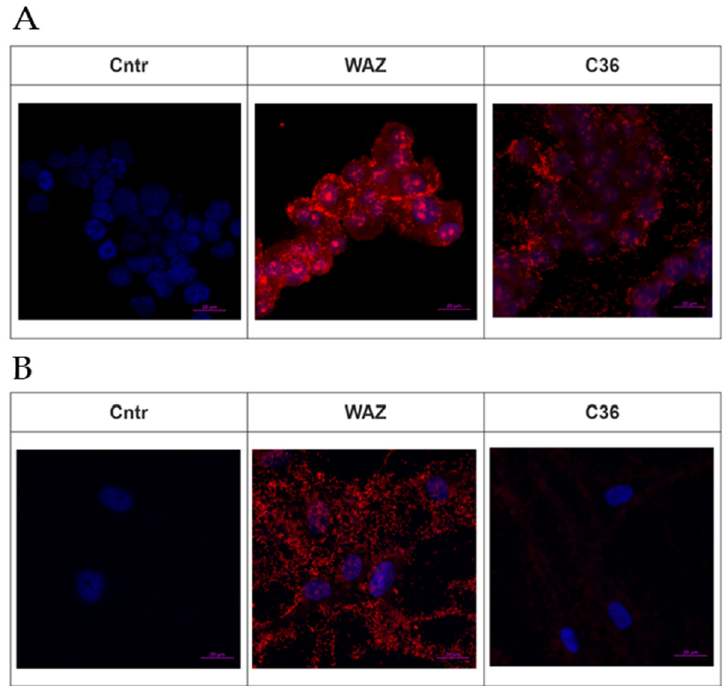
Figure 1. Cytochemical staining of U-87 MG human glioblastoma cells ( A ) and normal human fibroblasts hFF8 ( B ) using a SulfoCy5-labeled Waz 2 (cid:48) -F-RNA aptamer and scrambled control RNA C36 (see Materials and Methods section (Section 4.5) for abbreviations and nucleotide sequences). DAPI-stained nuclei, blue signal; Cy5-labeled aptamers and scrambled controls, red signal. On the contrary, control scrambled 2 (cid:48) -F-RNA oligonucleotide C36 (sequence taken from [20]) demonstrated weak penetration into the cytoplasm and nuclei of tumor cells.